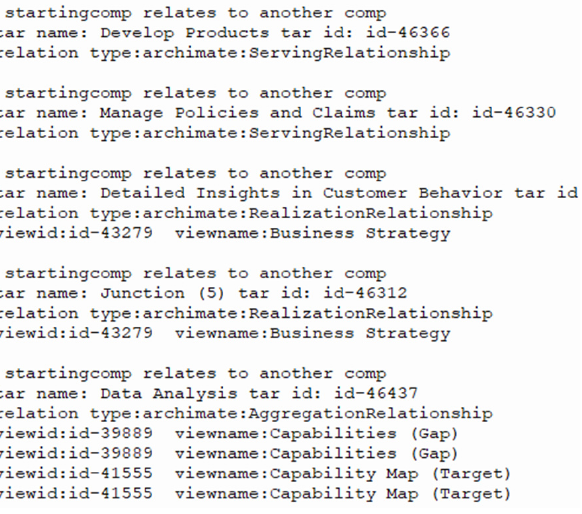
Figure 8. Intermediate results of performing an EAS automatic searching.